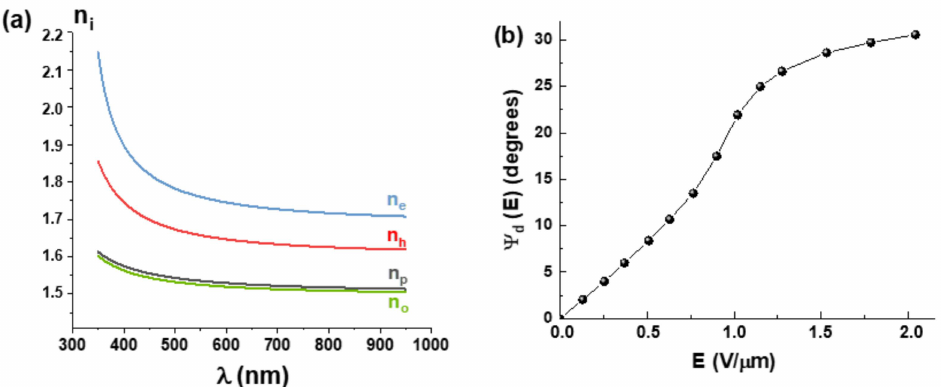
Figure 6. ( a ) Dispersions of refractive indices of the FLC-618; ( b ) the main optical axis rotation angle